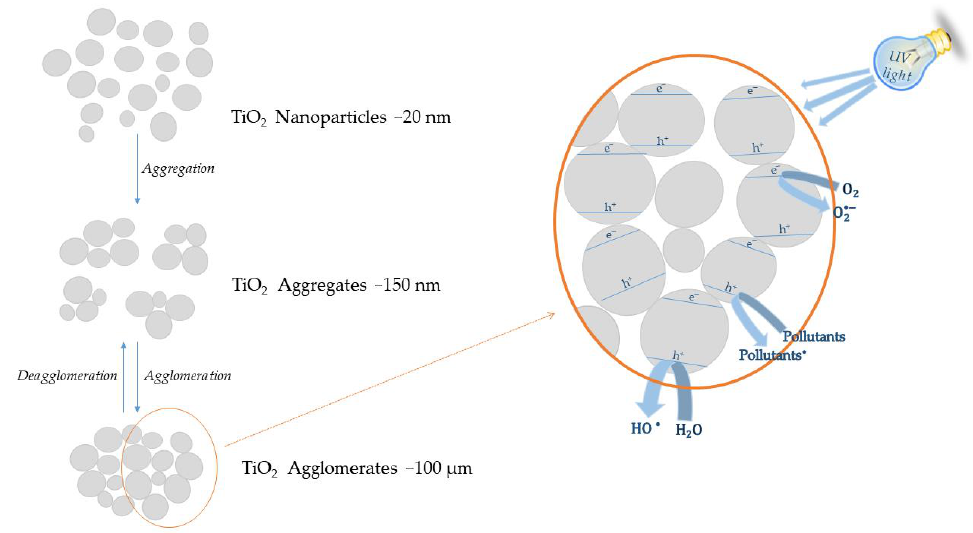
Figure 6. Illustration of the aggregation/agglomeration of TiO 2 and increased photocatalytic activity through energy transfer.